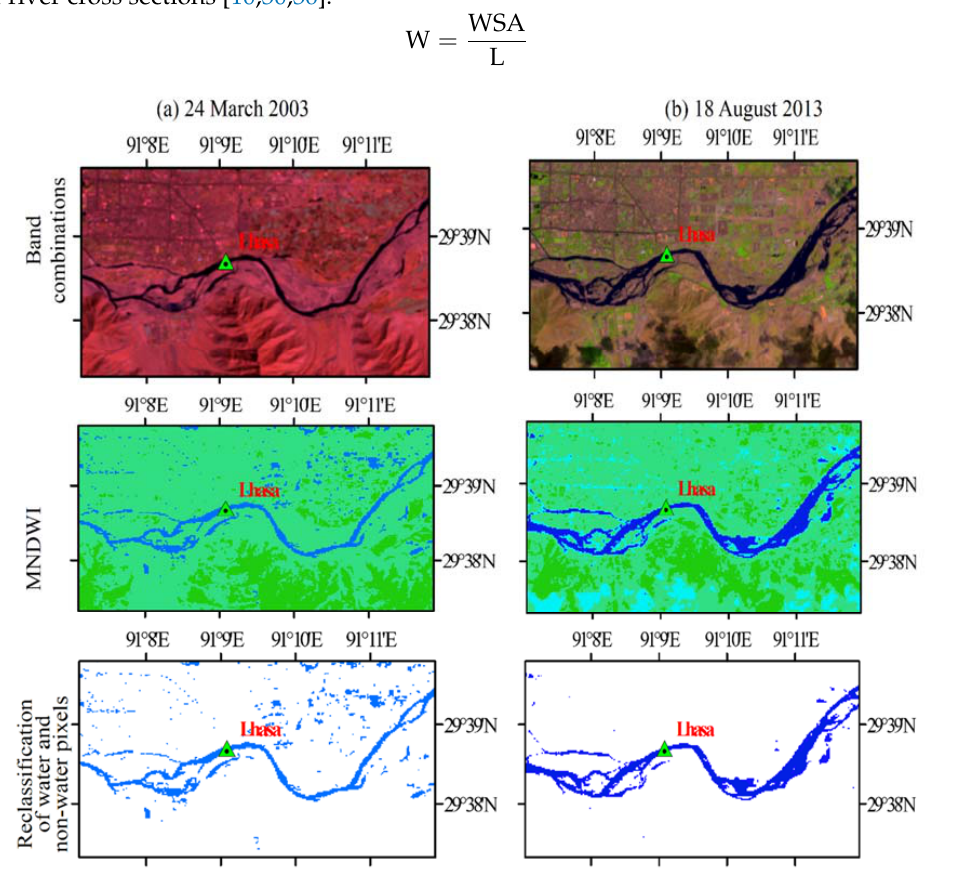
Figure 2. ( a ) An illustrations of Landsat image analysis and classification acquired on 24 March 2003; ( b ) on 18 August 2013, among the 363 cloud free Landsat images used in this study to extract the Lhasa River water body via the modified normalized difference water index (MNDWI) approach and to estimate the reach ‐ average width (ratio of water surface area (WSA) to the reach length). Several studies have shown that the in ‐ bank river width can be successfully estimated using